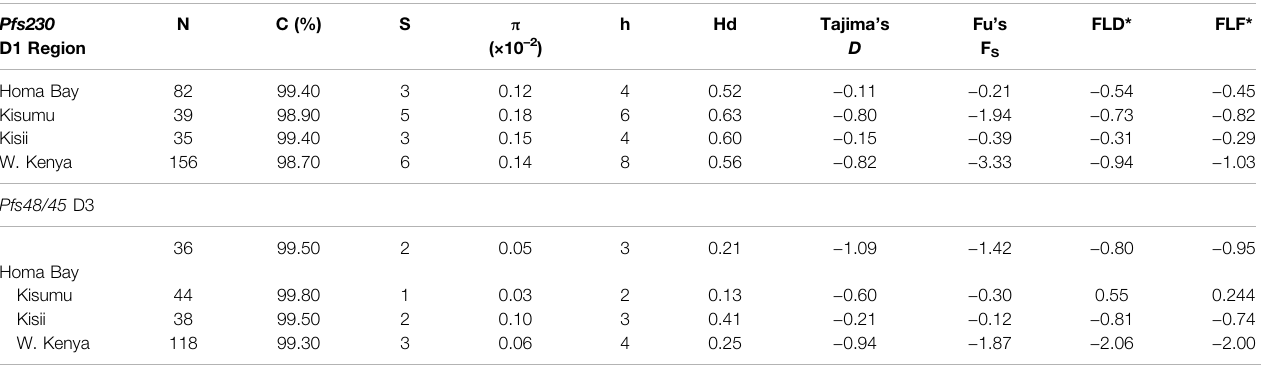
TABLE 2| Summary ofgenetic diversity indices for Pfs230 domain one and Pfs48/45 domain three from parasites in western KenyaN: Sample size;C: Conservation index; S: Segregating sites; π : nucleotide diversity; Vars: Variants; Hd: Haplotype diversity.